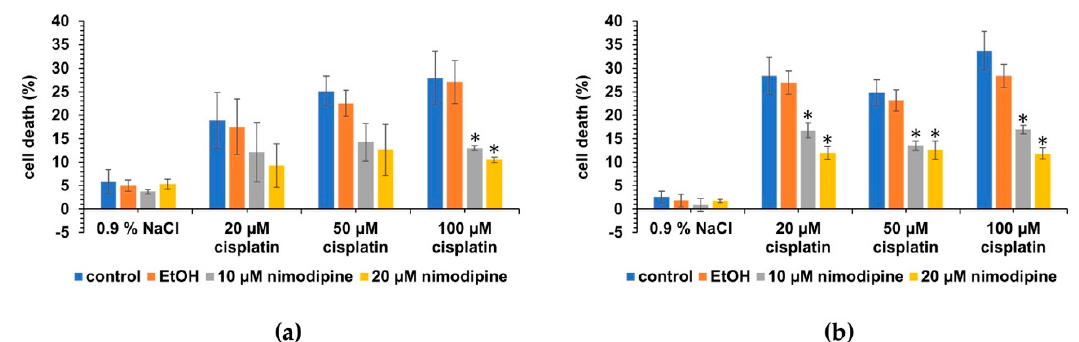
Figure 2. Prevention of cisplatin - induced cytotoxicity by nimodipine in auditory hair cells. The 5 × 10 4 cells were seeded and treated with nimodipine, and cisplatin as described in the methods and materials section. To investigate the cell death rate, the LDH activity in the culture supernatant was measured 24 h after stress induction. A reduction in cell death induced by cisplatin treatment by pre-treatment with 10 µM and 20 µM nimodipine was visible in both UB/OC − 1 ( a ) and UB/OC − 2 ( b ) cells. Between cells treated with EtOH (0.1%, solvent) and untreated cells, there was no reduction in cytotoxicity. p values < 0.05 (* p < 0.05) compared to cells treated with EtOH death rates were accepted as significant. The mean values and standard deviations of three independent biological replicates are shown.